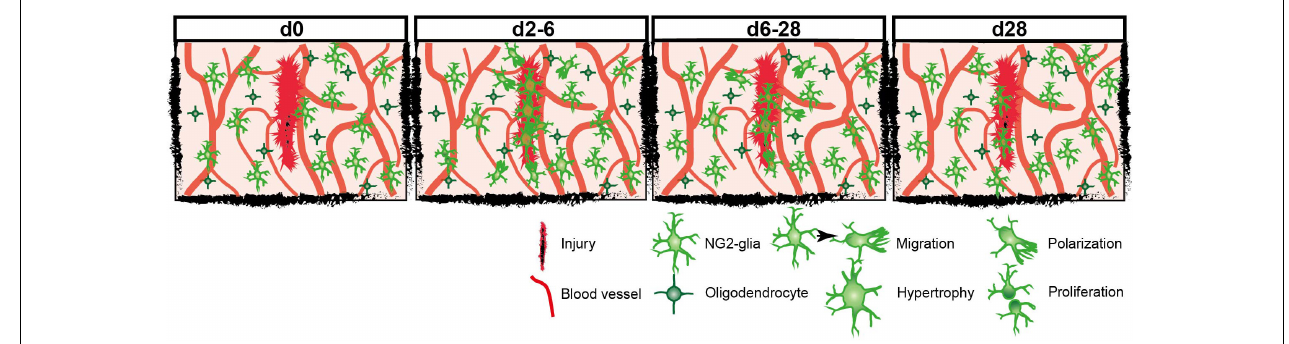
FIGURE 6 | Model scheme of the reaction of NG2-glia at different timepoints after